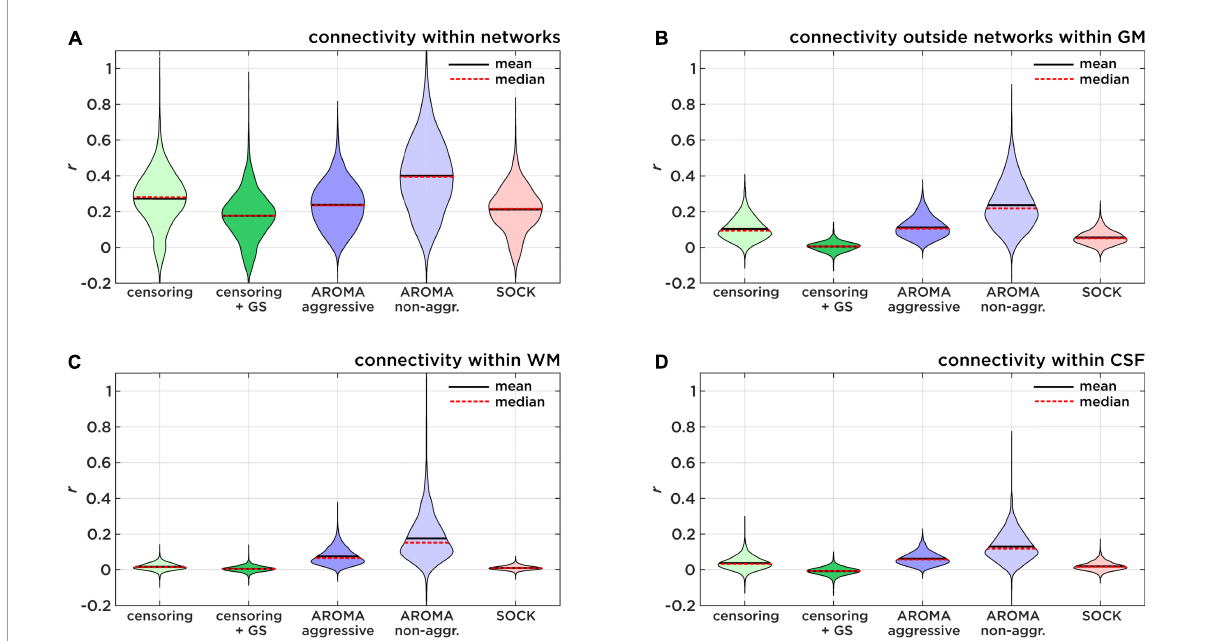
FIGURE6 Identifiability sub-scores of connectivity. Comparison of true positive and false positive connectivity of each regression approach, investigating the low identifiability score of non-aggressive AROMA. (A) Shows the mean connectivity within target network regions (true-positive). (B) Shows the mean connectivity within the gray matter (GM) but outside of the target network regions (false-positive). (C) Shows the mean connectivity within the white matter (WM) and (D) shows the mean connectivity within regions of the cerebral spinal fluid (CSF) as measures of physiological noise-induced